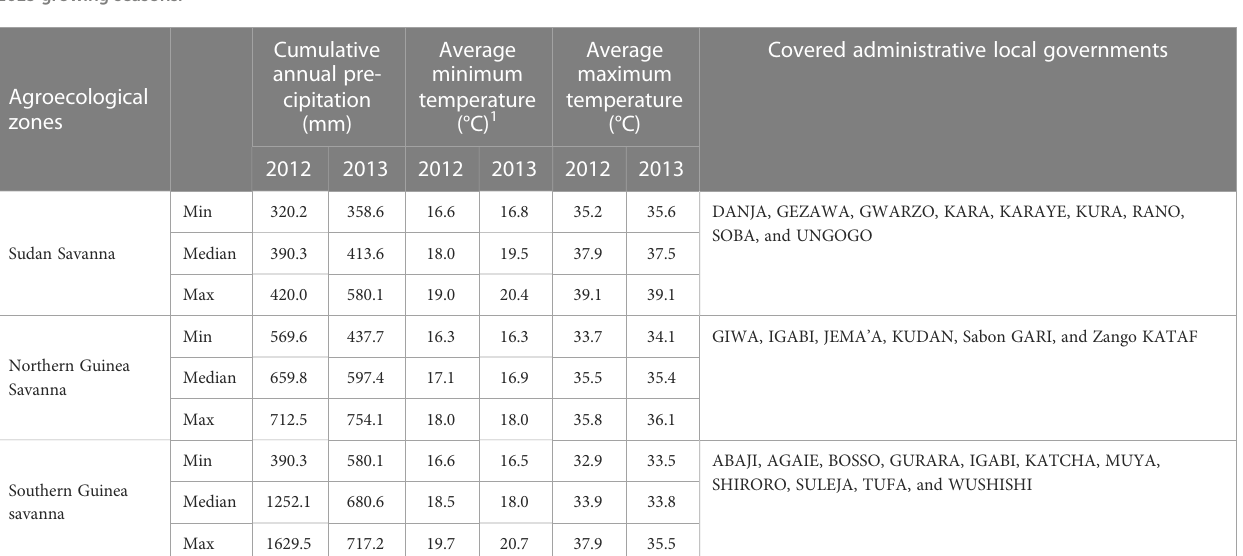
TABLE 1 Minimal (min), median, and maximum (max) of cumulative monthly precipitation (mm), average of minimal and maximal temperature, and covered administrative local governments of studies in the Sudan, Northern Guinea, and Southern Guinea Savannas of Nigeria recorded for 2012 and 2013 growing